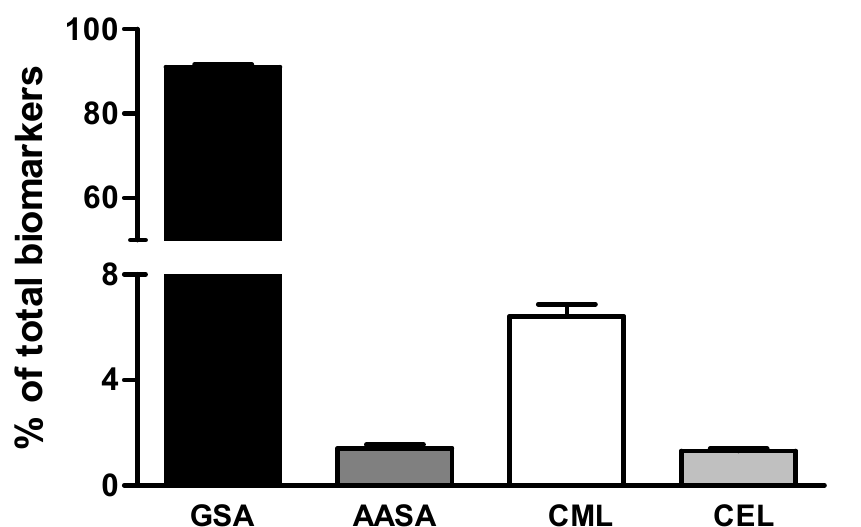
Figure 2. Biomarkers of protein oxidative modifications in follicular fluid. Values were measured in samples from a natural cycle. Bars represent the mean + SE of the percentage of total protein oxidative modifications.